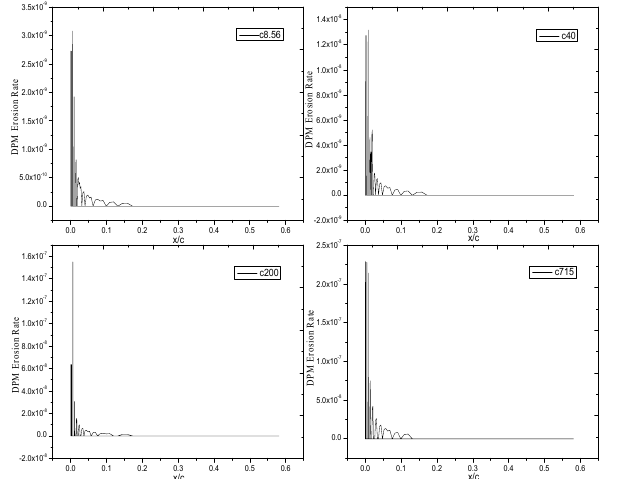
Figure 12. Distribution of erosion position and erosion degree of airfoil shape under different concentrations of particles.